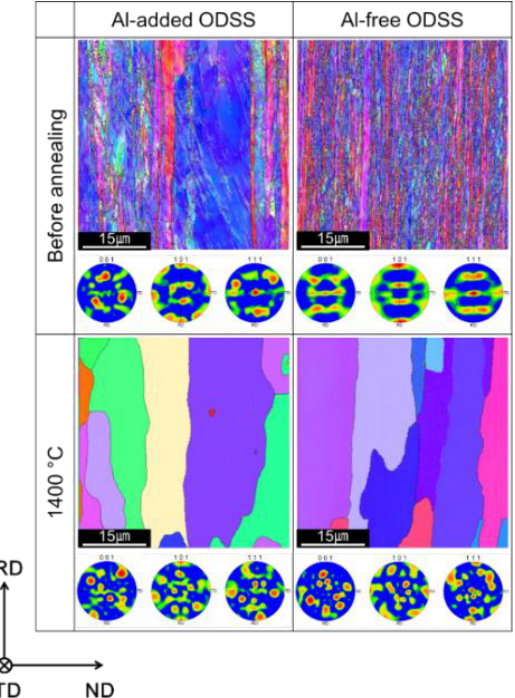
Figure 13. Grain orientation map and pole figure of EBSD analysis before and after annealing at 1400 °C of both Al-added and Al-free ODS ferritic steel.